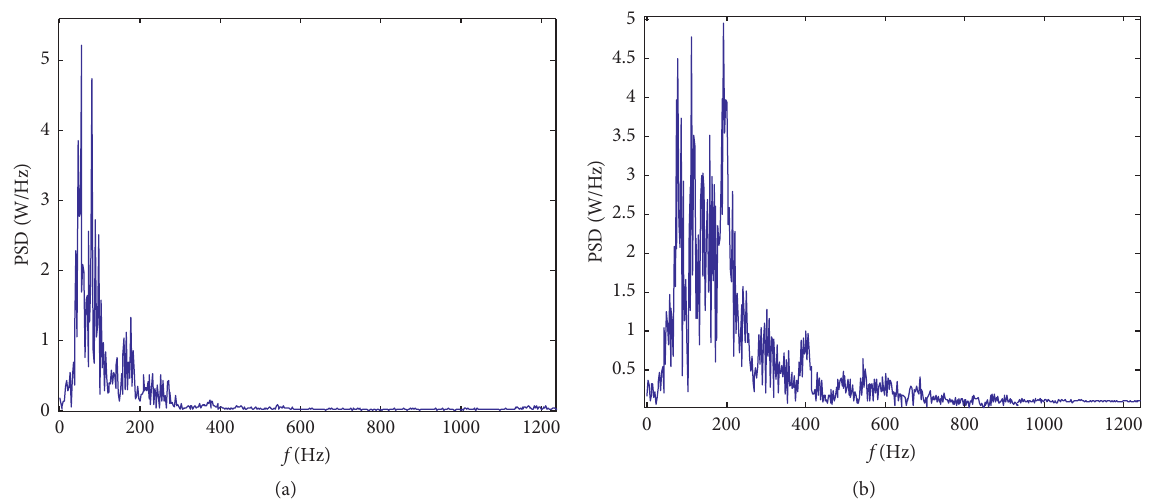
Figure 4: Power spectrum density wave of the (a) usual charge and (b) cutting seam charge.